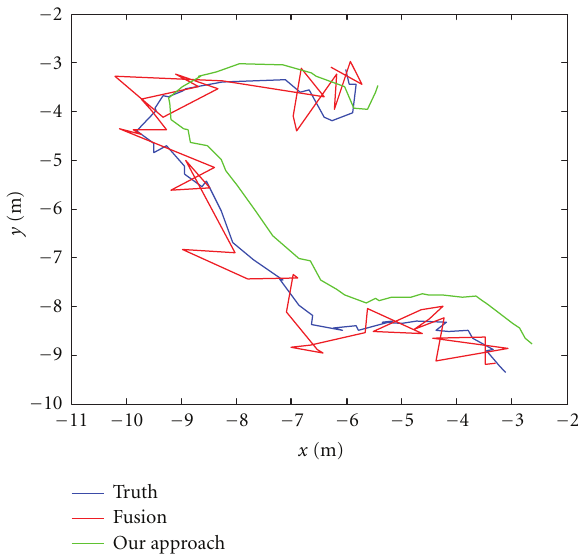
Figure 17: Trajectory in world coordinate